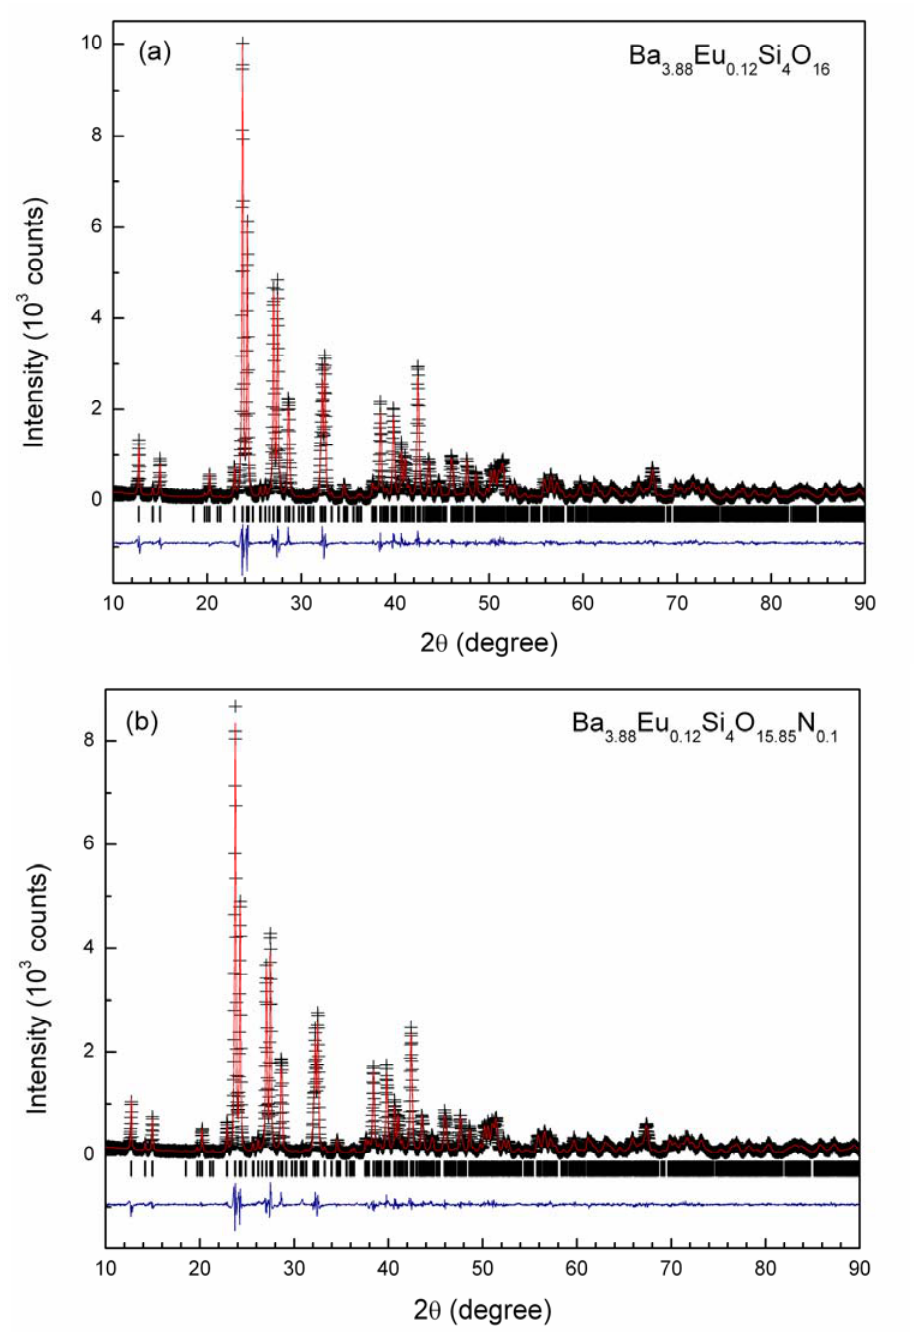
Figure 4. Rietveld refinement of X-ray diffraction patterns for Ba x = 0 and (b) x = 0.1. The observed counts are indicated by crosses and the calculated pattern by a solid line. The residual curve is shown in the bottom of the diagram. The vertical bars indicate the position of Bragg